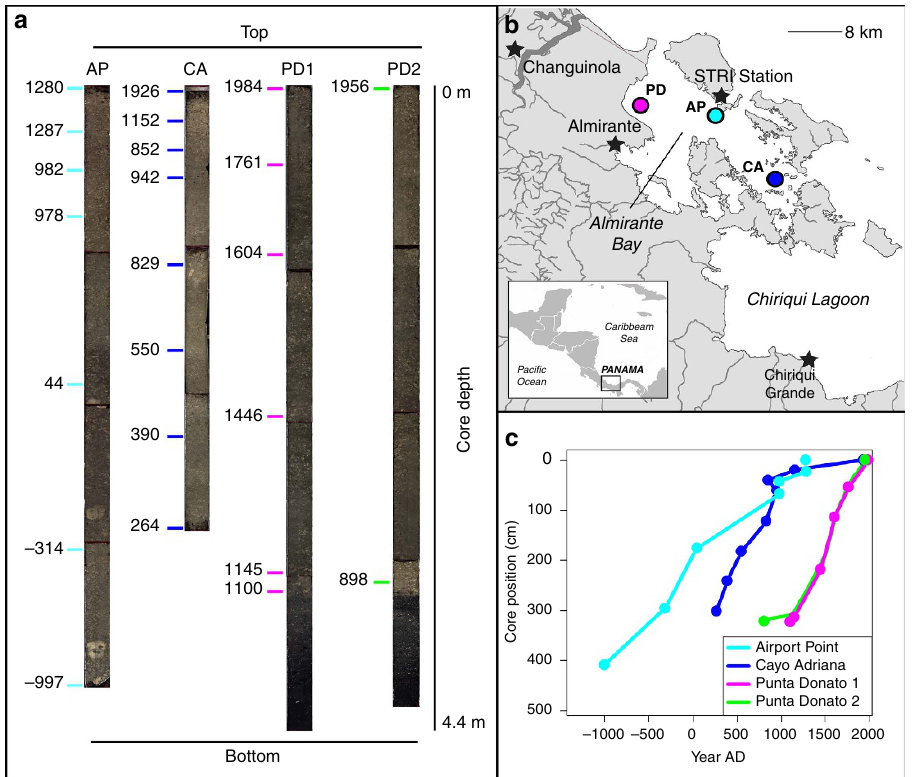
Figure 1 | Reef accretion rates over last 3,000 years in Bocas del Toro, Panama. ( a ) Reef matrix cores (n=4) analysed for subfossil and sediment composition and U–Th dates ( n ¼ 23) obtained (in year AD) along length of cores. AP ¼ Airport Point, CA ¼ Cayo Adriana, PD1 and PD2 ¼ replicate cores from Punta Donato. ( b ) Map of coring locations. Stars indicate population centers, including Smithsonian Tropical Research Institute (STRI)’s research station. Turquoise ¼ AP, blue ¼ CA, pink and green ¼ PD1 and PD2, respectively. ( c ) Age-depth plot showing reef accretion trends Age reversals excluded from linear interpolations of age estimates; rates for PD2 were assumed to be equivalent to those for same core position in